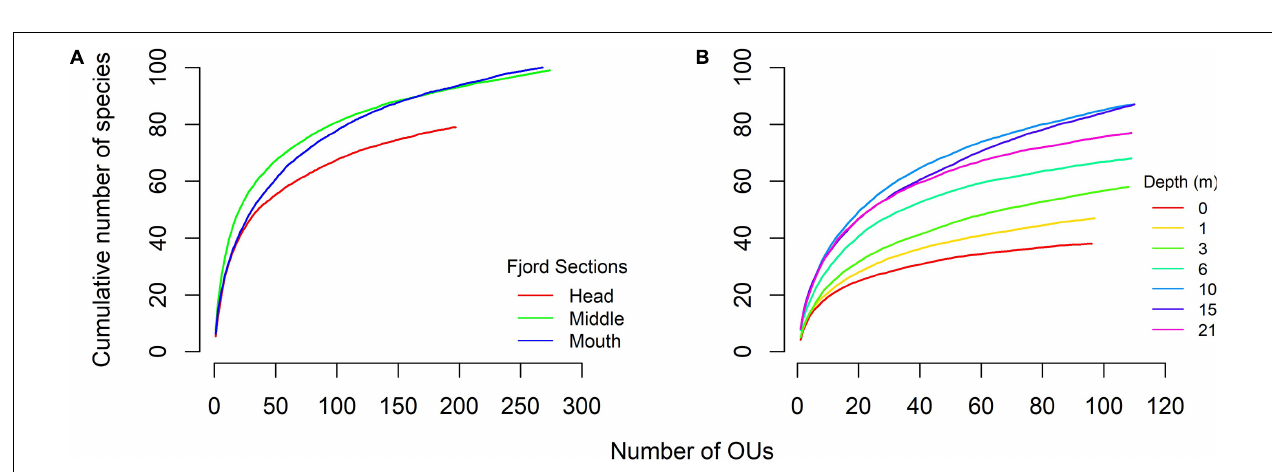
FIGURE 3 | Species-accumulation curves (SACs) of macrobenthic communities of Comau fjord. Separates SACs were performed for each (A) fjord sections and (B) depth strata. Cumulative number of species is shown as mean from each random combination of OUs (0.28 m 2 ).